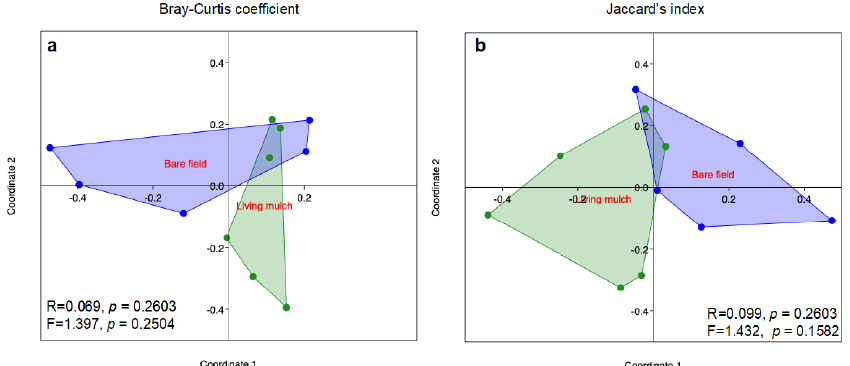
Figure 6. Fungal endophyte communities as influenced by cultivation practice. Nonmetric multidimensional scaling (NMDS) and ANOSIM analysis of endophyte communities recovered from site-D from two cultivation practices as indicated by different colors as well as labels. For clustering analysis, two different community similarity indices were computed: ( a ) Bray–Curtis coefficient, which compares fungal taxa presence or absence along with the abundance among groups, and ( b ) Jaccard’s index uses only presence and absence data for comparing fungal community similarity among groups. The ANOSIM statistic R and The PERMANOVA statistic F values and the corresponding p -values indicating the significance of dissimilarity were obtained by permutation of group membership, with 9999 replicates.